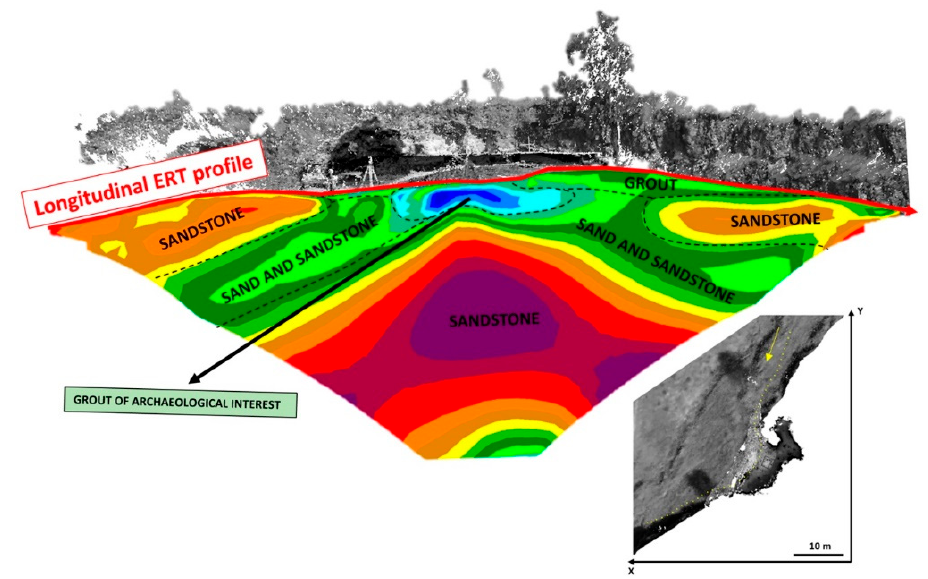
Figure 12. Results obtained from the transversal Electrical Resistivity Tomography profile (profile 2).